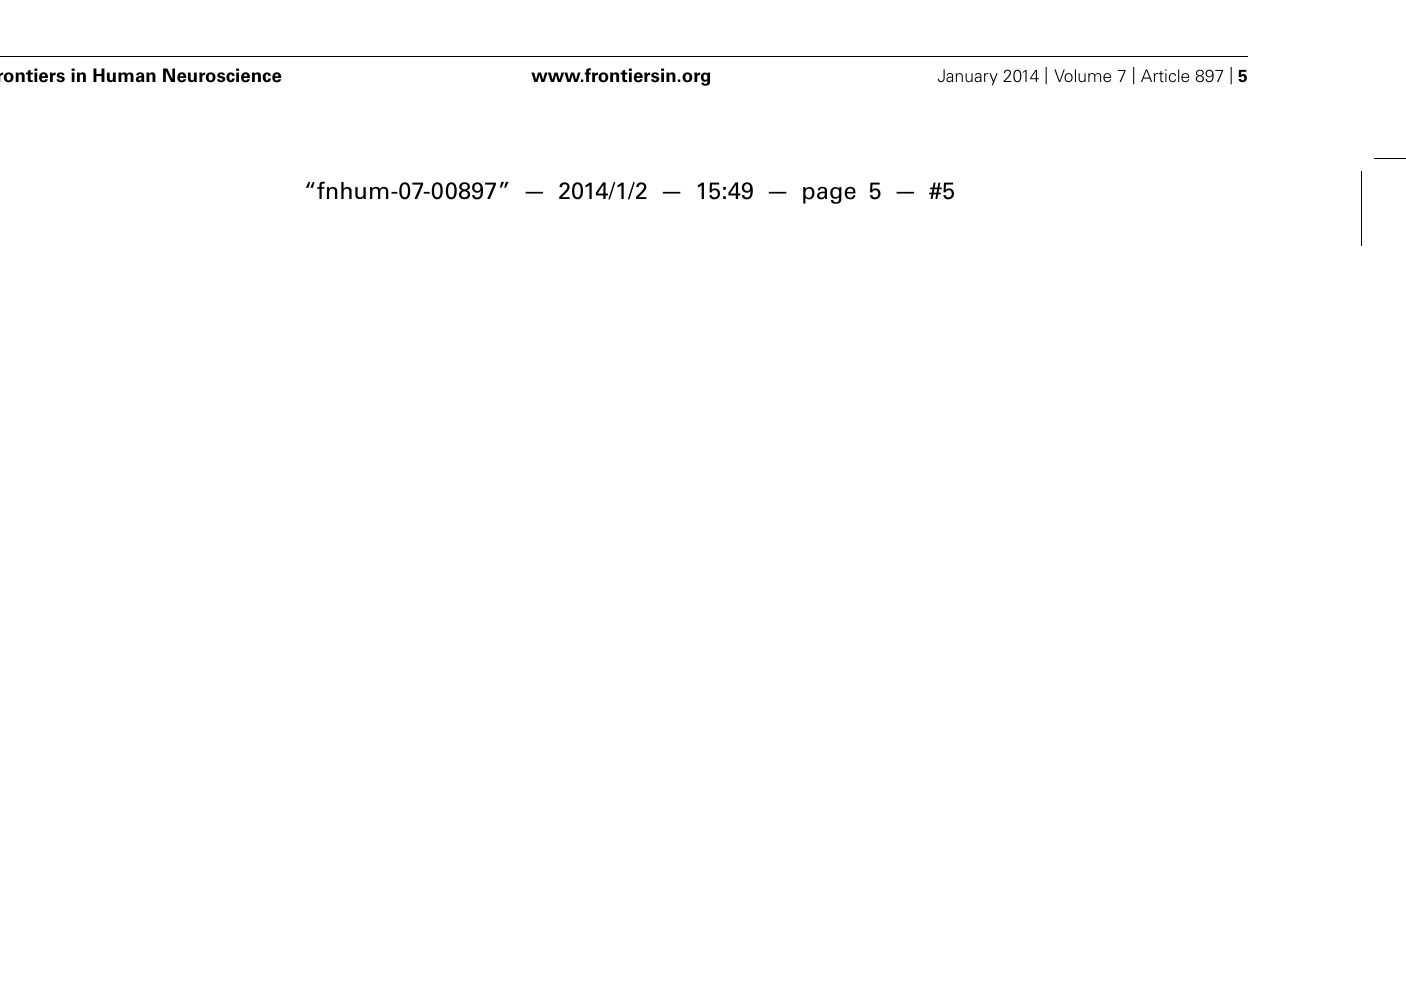
FIGURE 2 |Trial sequences and timing for the three computerized tasks that were administered prior to and following the 7 week training interval. In the SART, participants viewed a string of single digit numbers and were instructed to key press in response to any digit except three (non-target) and to withhold response when a three was presented (target). During the task, self-report probes intermittently asked participants about attention and